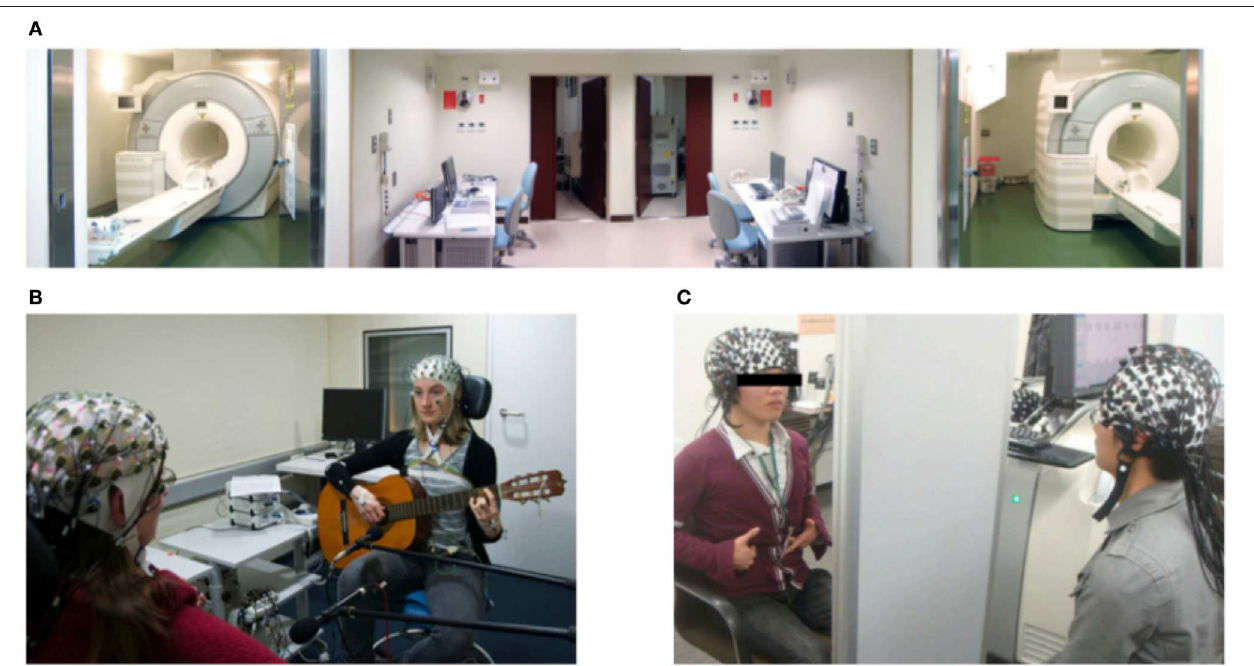
FIGURE 1 | Neuroimaging methods used in Hyperscanning. (A) From Koike et al. (2019). View of the dual fMRI facility used to study mutual gaze. (B) From Acquadro et al. (2016). EEG measurement of two guitar players. (C) From Osaka et al. (2015). fNIRS set up used to study cooperative singing. All parts reproduced/adapted under CC